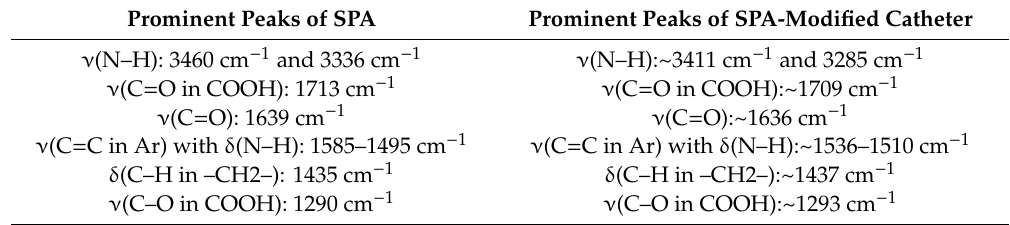
Table 3. Summary of the FTIR analysis of the SPA-modified catheter following the SPA-M3 method. Prominent Peaks of SPA Prominent Peaks of SPA-Modified Catheter